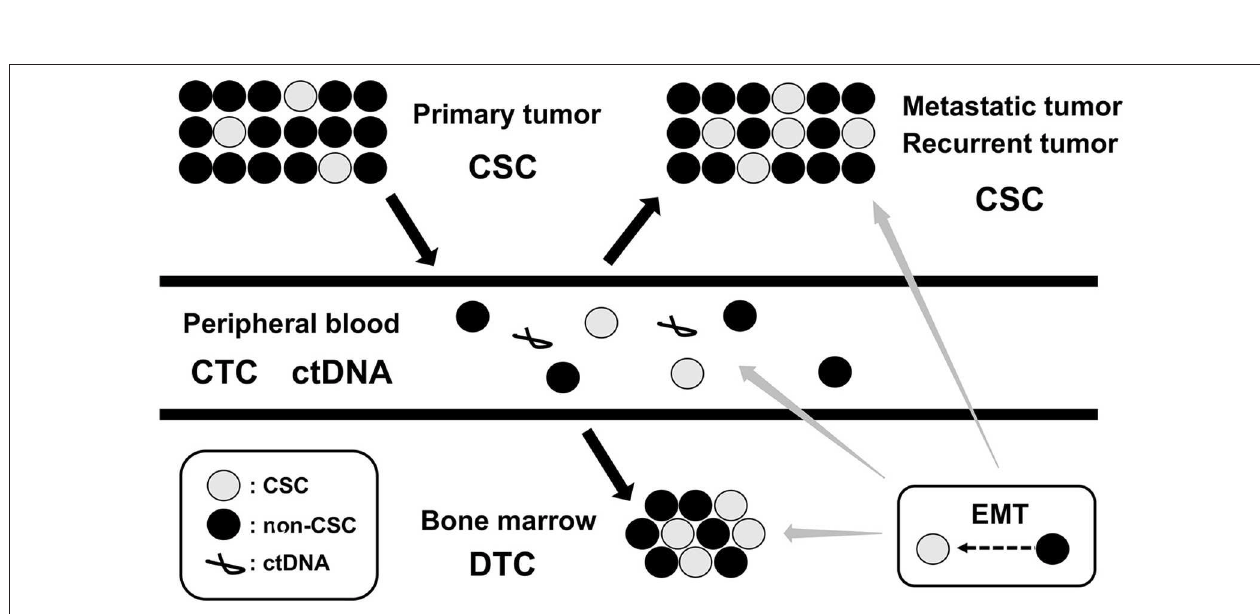
FIGURE 2 | Dynamics of MRD. MRD, minimal residual disease; CSC, cancer stem cell; CTC, circulating tumor cell; DTC, disseminating tumor cell; ctDNA, circulating tumor DNA; EMT, epithelial-mesenchymal transition.